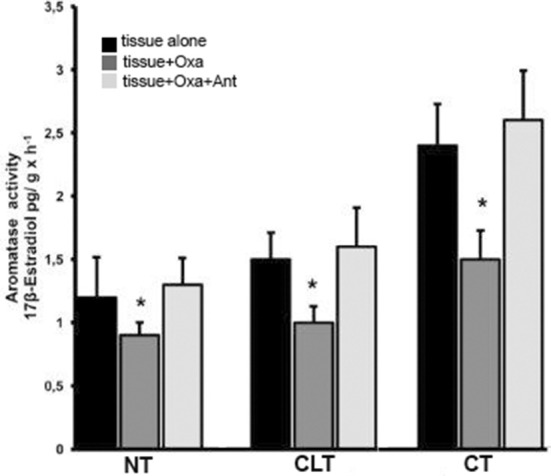
ARO activity evaluated with in vitro tests carried out in normal, cryptorchid, and contralateral dog testis. Testicular slices were incubated in presence of testosterone alone, with OxA, or with both OxA and the OX1R antagonist SB-408124 and 17βE production monitored. Values are normalized per g tissue per hour. Data are expressed as mean ± SD (n = 5 samples/group), *p < 0.01.